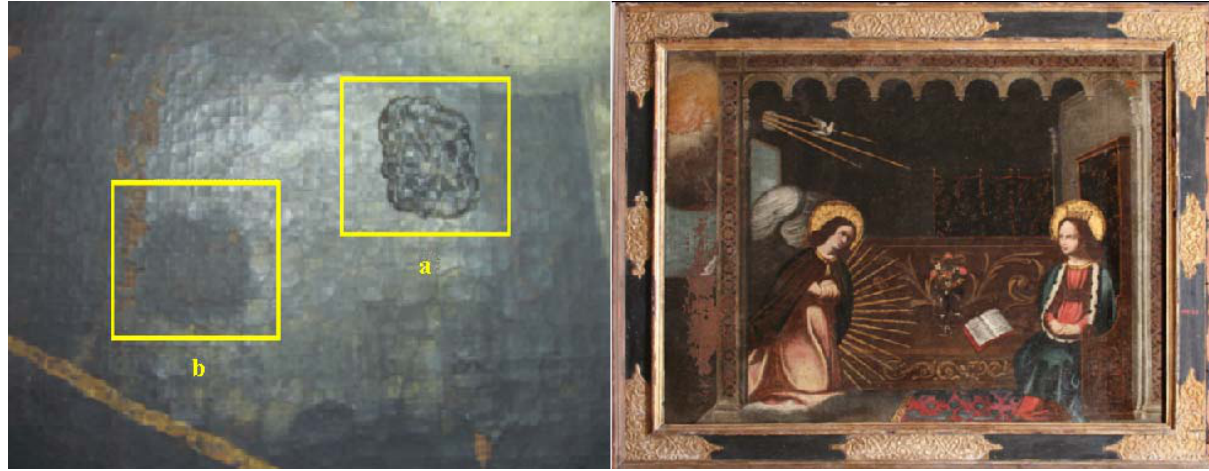
Figure 1. Paint art-work “ Annunciazione ” Century XVII. Regional Gallery of Sicily, Palazzo Abatellis - Palermo (Italy). Left, detail of the art-work: (a) applied gel and (b) removed gel; right, art-work after the cleaning process. From Ref.